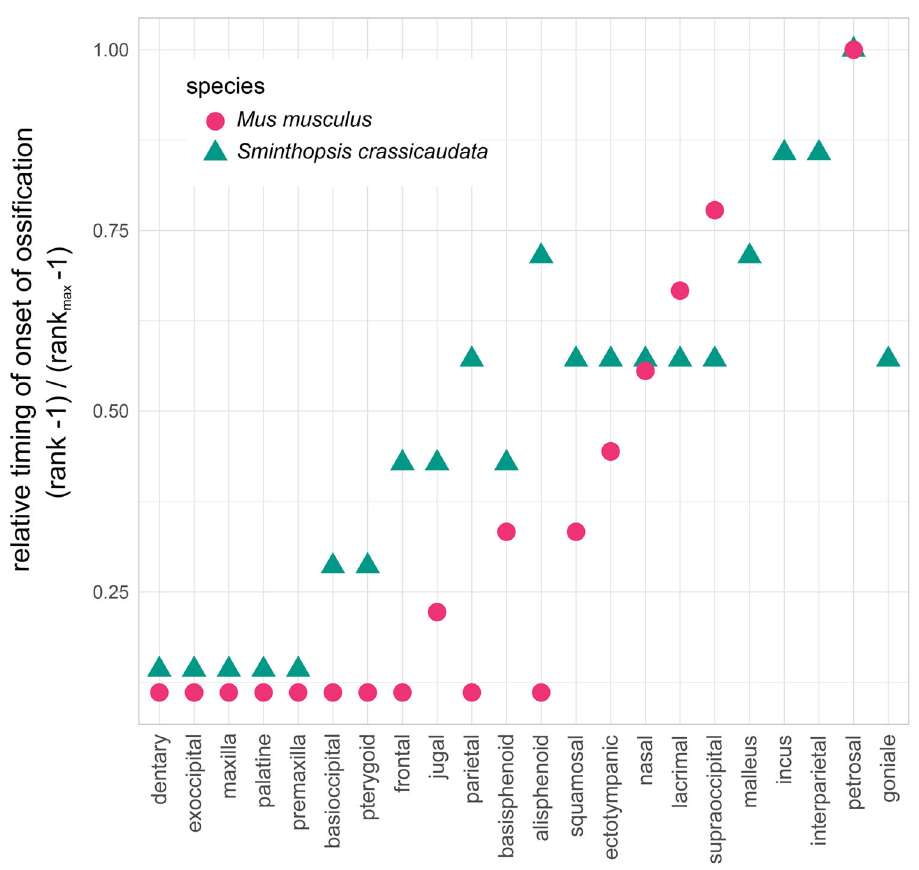
Fig. 5 Relative timing of onset of ossi fi cation for the bones of the skull in the fat-tailed dunnart ( S. crassicaudata ) and mouse ( M. musculus ). Specimens were ranked in order of bone onset or bone contact timing and relative ranks were normalised for comparison between species. M. musculus is shown with pink circles and S. crassicaudata is shown with green triangles, highlighting the early onset of ossi fi cation of the oral region in both species.